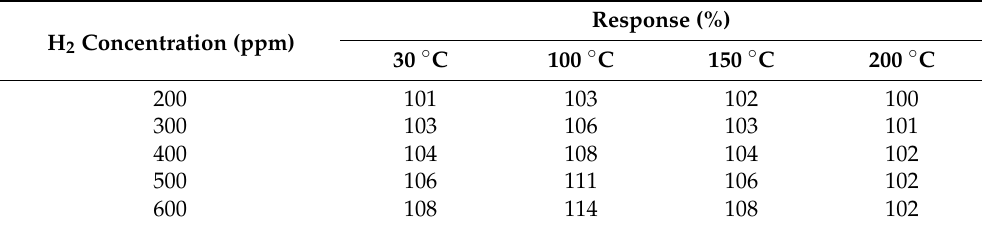
Table 1. Hydrogen sensing response of CeO 2 -Pd-PDA/rGO heterojunction nanocomposite at differ- ent operating temperatures and H 2 concentrations in the dark. H 2 Concentration (ppm)